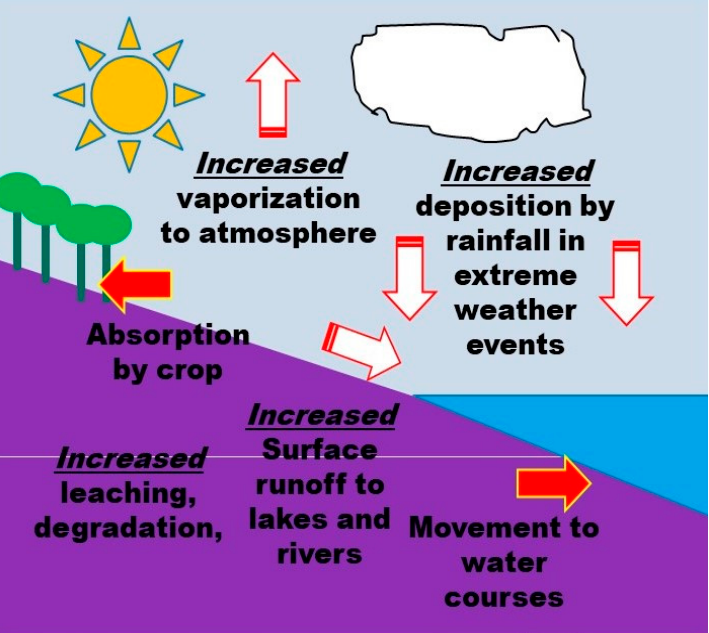
Figure 4. Climatic factors affect the environmental behavior of pesticides (by